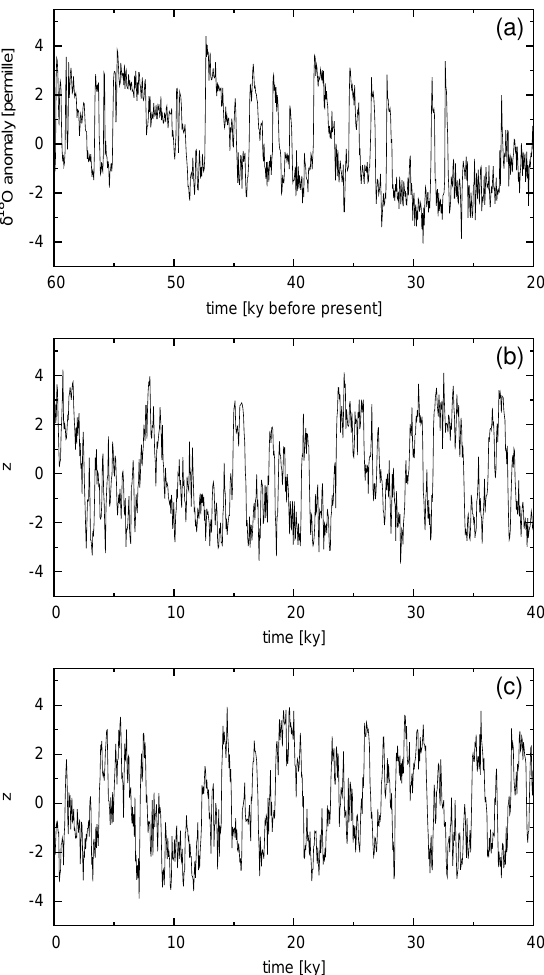
Fig. 7. Ice-core data: (a) Estimates for a 4 /γ and a 3 /γ with er- ror standard deviation. (b) Estimates for a 2 /γ with error standard deviation and estimates for a 1 /γ . (c) Scaled potential V (z)/γ for the oscillator model (thick solid) and potential U(z) for the one-dimensional model (thick dotted). Probability densities of the ice-core data (solid), the oscillator model (dotted) and the one- dimensional model (dashed).